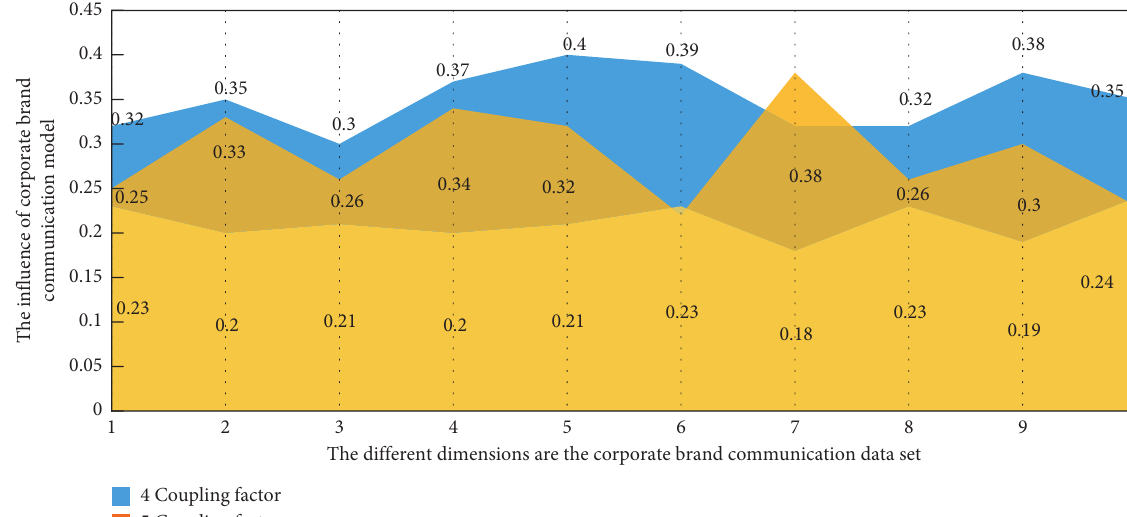
Figure 5: Simulation results of optimized PSO algorithm for solving optimization